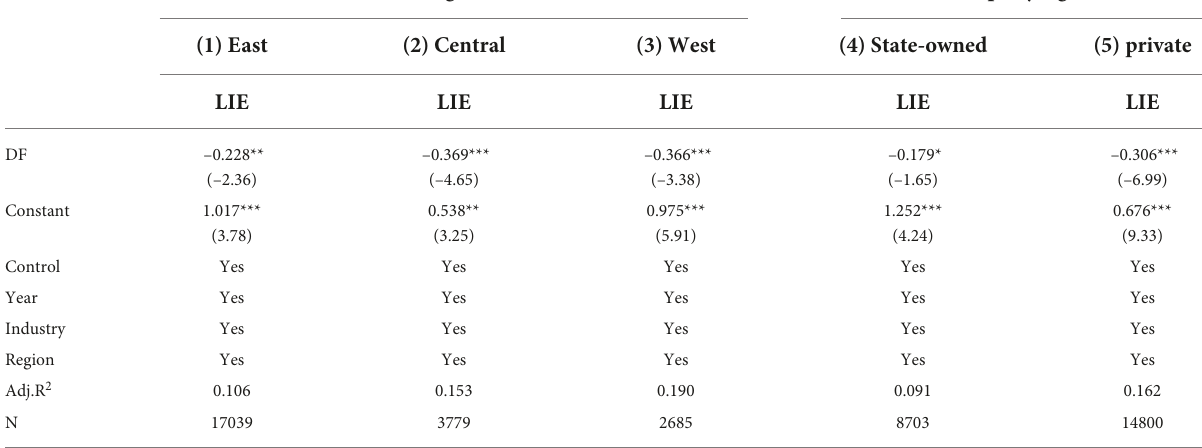
TABLE 11 Heterogeneity